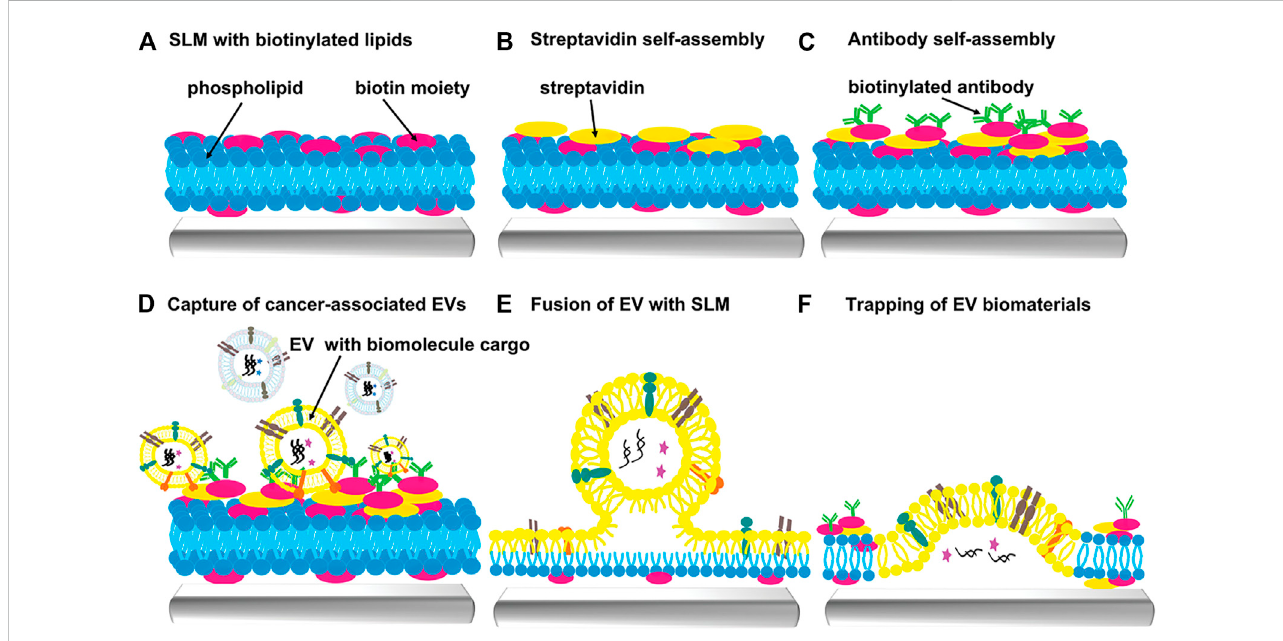
FIGURE 5 Scheme of extracellular vesicles capture by supporting lipid membranes (SLM). (A) Fabrication of biotinylated SLM arrays can be achieved by L-DPN. (B) Biotinylated SLM arrays are encapsulated with streptavidin. (C) Biotinylated antibodies can bind to the SLM arrays to capture speci fi c EVs. (D) Cancer-associated EVs are captured on the SLM arrays. (E) Fusion of EV with SLM. (F) Trapping of EV biomaterials (such as RNA, proteins). Reproduced with permission from (Liu et al.,